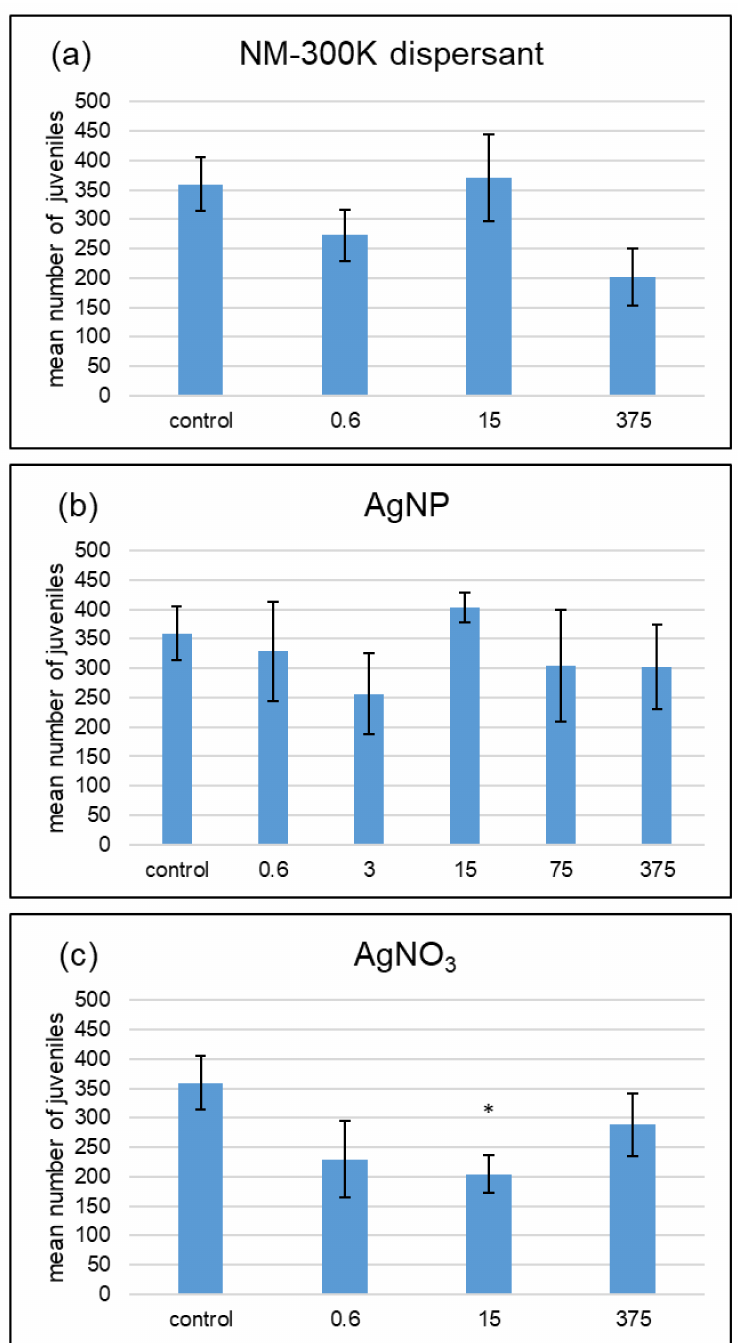
Figure 2. Effects of NM-300K dispersant ( a ), silver nanoparticles (AgNP) NM-300K ( b ), and AgNO 3 ( c ) at 40% maximum water holding capacity on F. candida reproduction. Results of a 28-day reproduction test based on the miniaturized OECD (Organisation for Economic Co-operation and Development) test of Filser et al. (2014) [21]. The unit is µ g Ag · kg − 1 soil, and the dispersant treatments contain the same amount of dispersant as the AgNP treatment labeled with the same concentration. Asterisks indicate significant statistical differences to the respective control (Wilcoxon test, p > 0.05). Mean number of juveniles ± SE, n = 5; control: n =